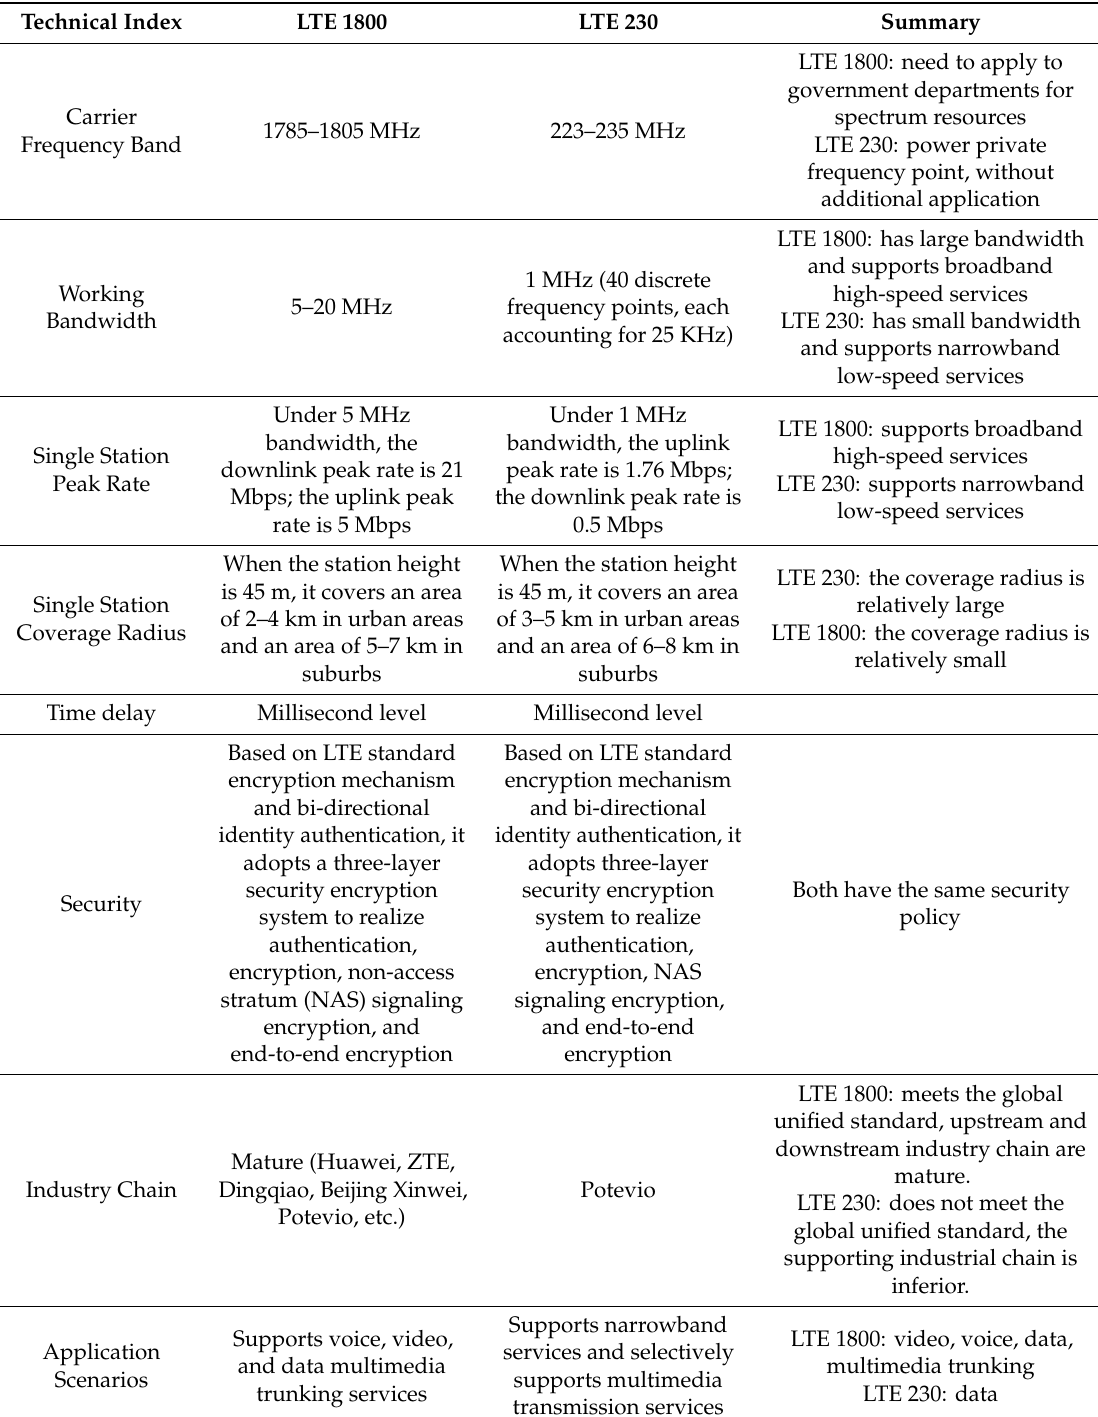
Table 1. Comparison of long-term evolution (LTE) 230 and LTE